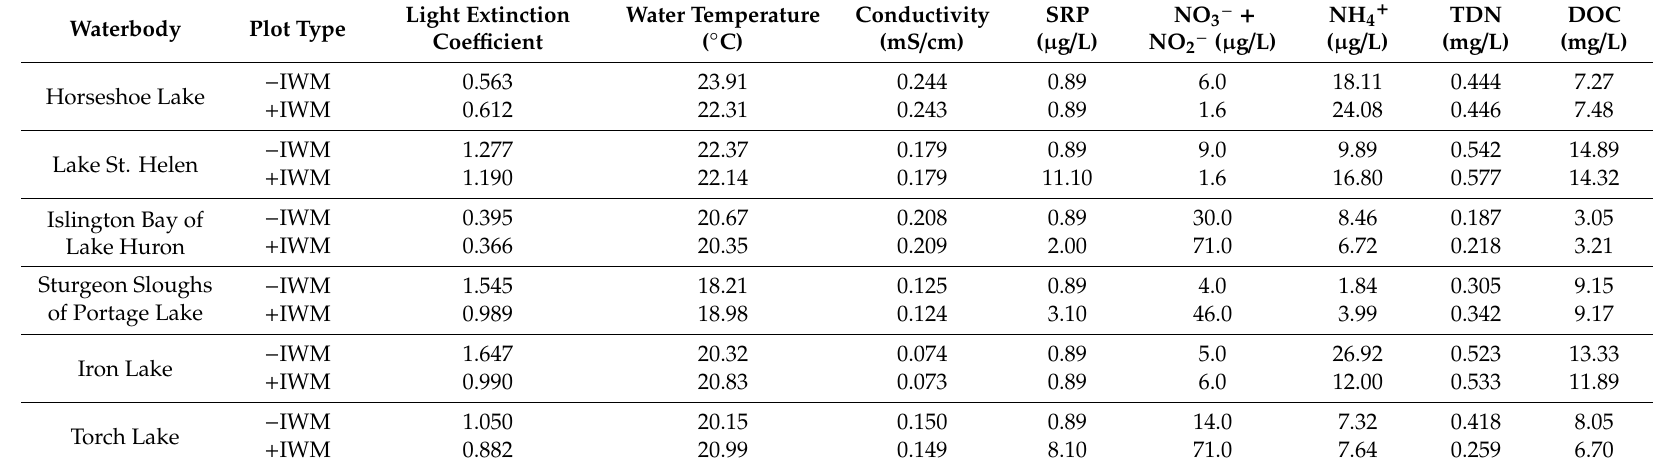
Table A1. Water characteristics and nutrient concentrations in paired + IWM and − IWM